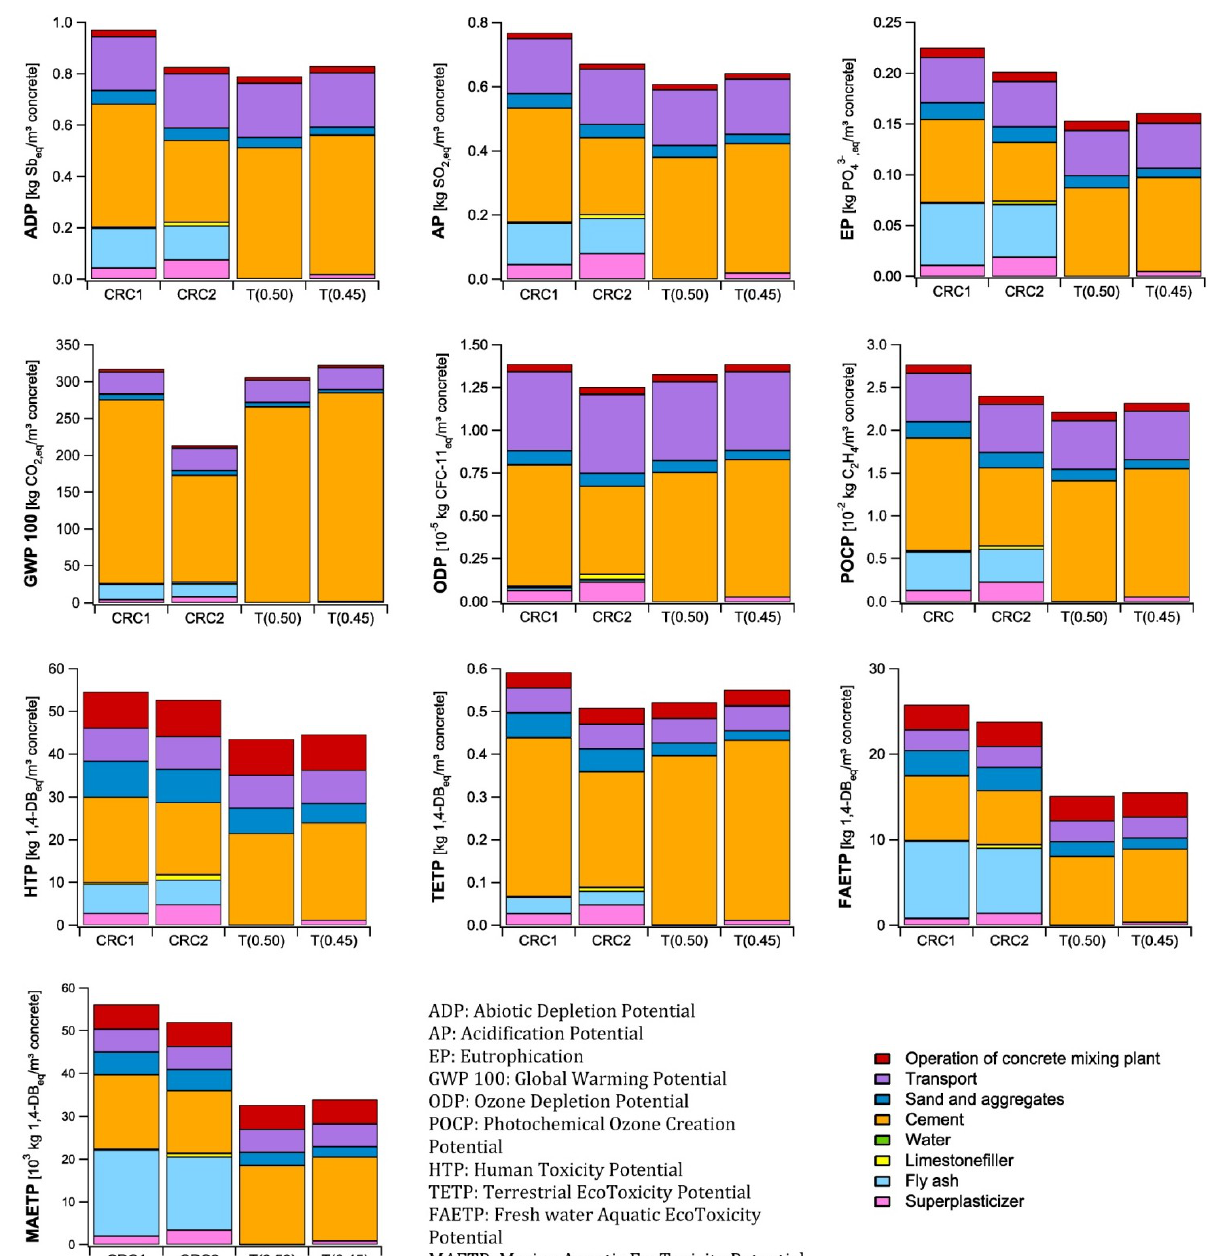
Figure 3. Life Cycle impact Assessment of 1 m 3